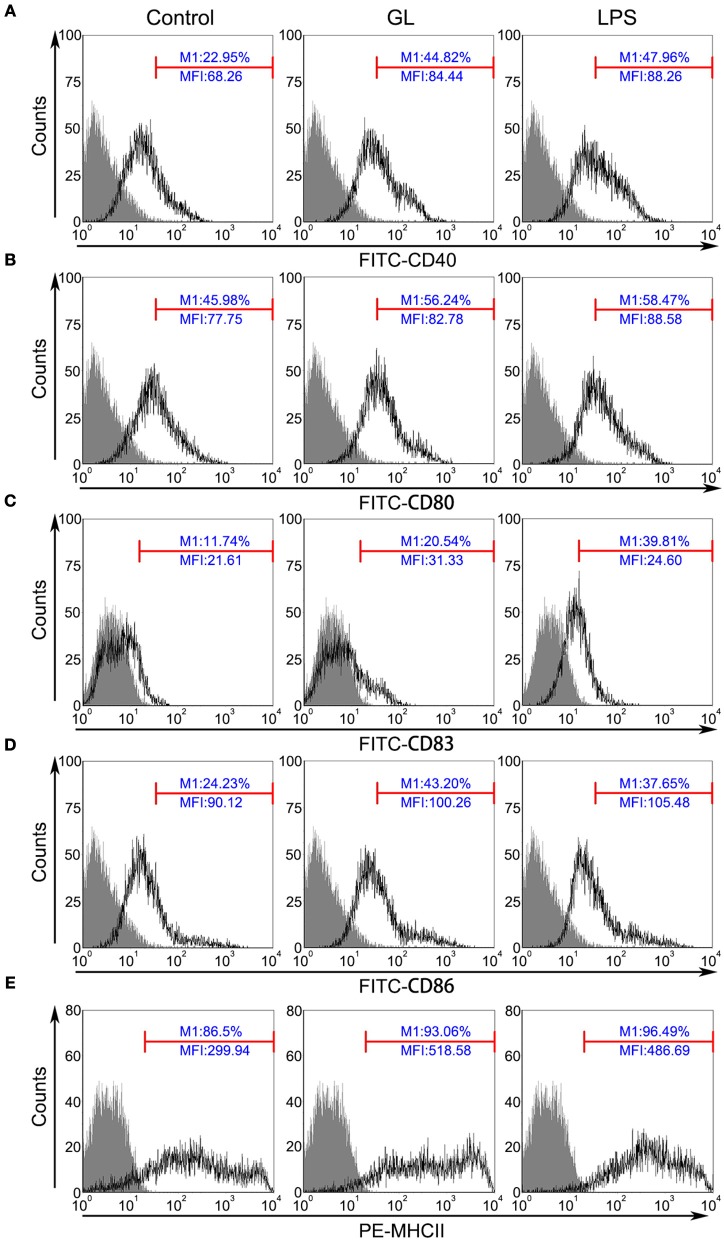
GL improves surface marker expression in BMDCs. BMDCs were treated with PBS (blank control), GL (200 μg/ml), or LPS (50 ng/ml; positive control) for 48 h. Cells were stained with antibodies against CD40 (A), CD80 (B), CD83 (C), CD86 (D), and MHC-II (E), and the fluorescence signals were determined immediately using a FACScan flow cytometer. At least 10,000 events were collected from the cell gate. The data represent three independent experiments.